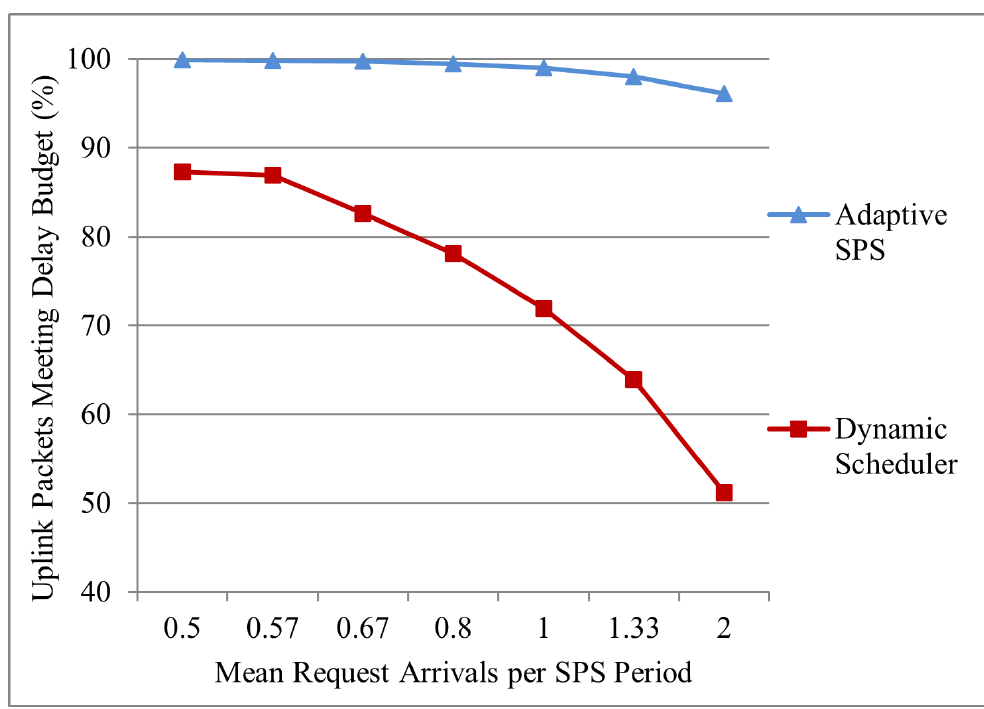
Figure 14. Percentage of packets meeting delay budget (90